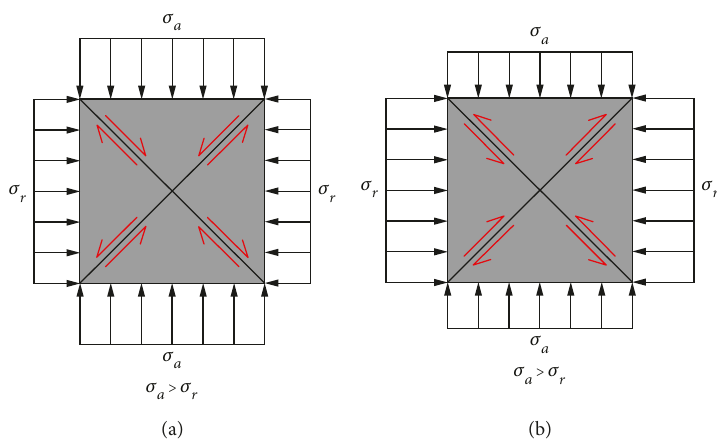
Figure 13: Various slip trends observed under di ff erent combinations of axial and radial